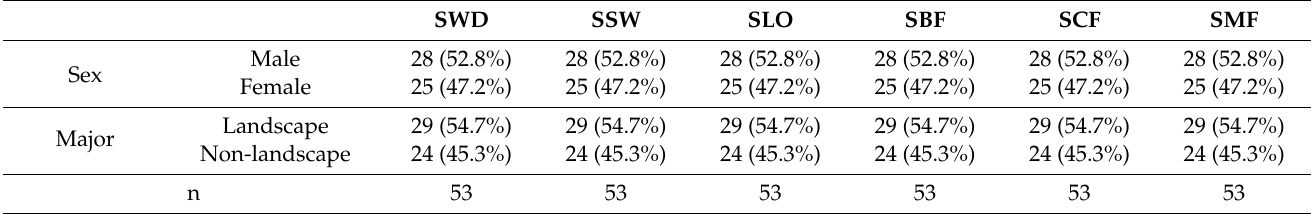
Table 3. Participants’ attributes. SWD: the space of dynamic water; SSW: the space of static water; SLO: the space of lookout; SBF: the space of broadleaf forest landscape; SCF: the space of coniferous forest landscape; SMF: the space of mixed forest